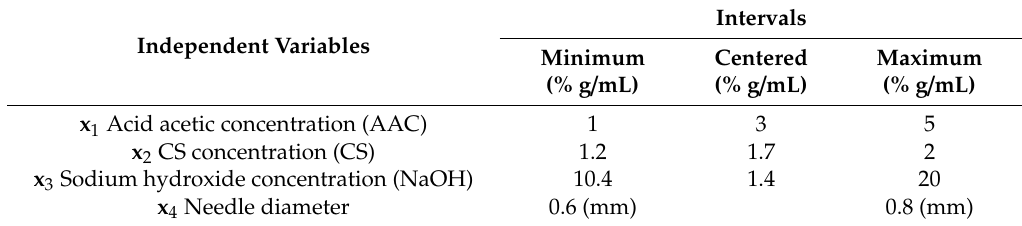
Table 1. Independent variables of the experimental design for the CS spheres synthesis.